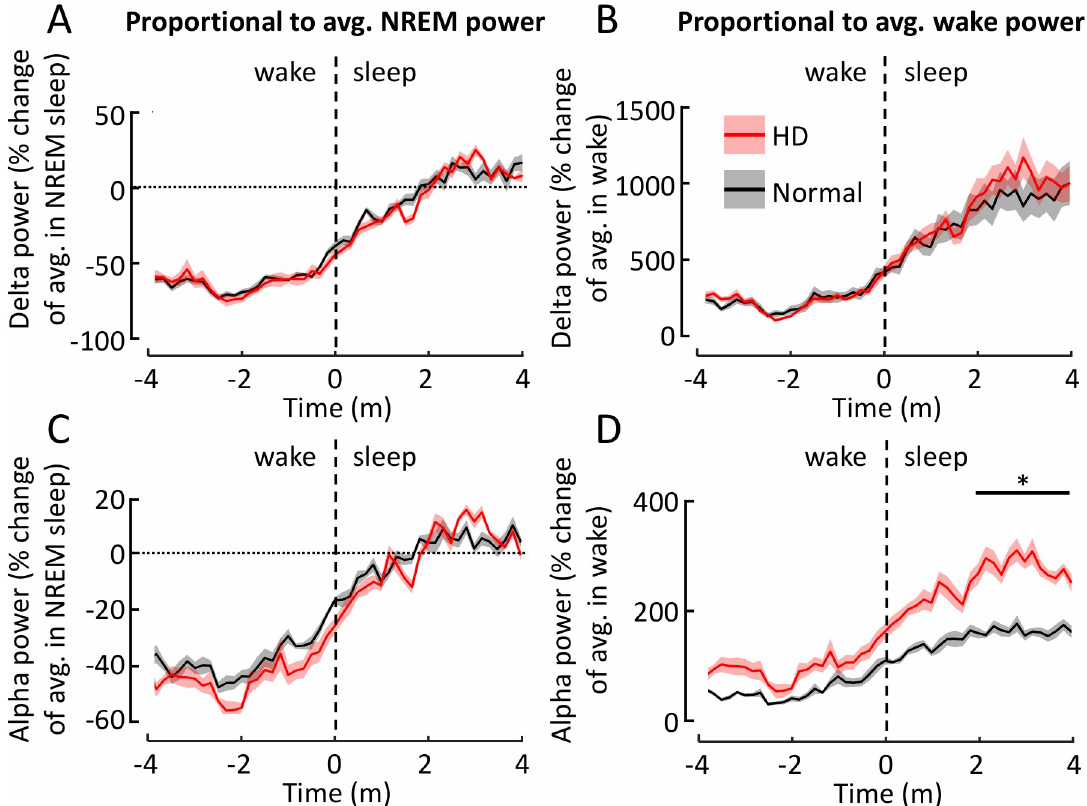
Fig 5. Similar changes in power during transitions from wake-to-sleep are seen in normal and Huntington’s disease sheep. Power changes across transitions from wake-to-sleep were calculated as the proportional change relative to the mean NREM sleep power ( A, C ) or wake power ( B, D ). Each trace represents proportional power changes for a particular frequency band in the mean transitions to sleep for all normal (black line) or HD (red line) sheep. Frequency ranges presented are delta ( A, B ) and alpha ( C, D ). The shading represents the standard error of the mean. For clarity data are shown only for the Fr2-L channel only. Statistics reported were performed with data from all channels included. avg. = average, � = P < 0.05, �� = P <